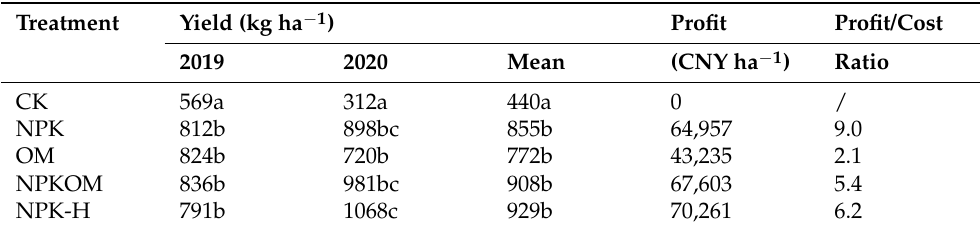
Table 2. Yield, profit, and profit/cost ratio of fertilization treatments.